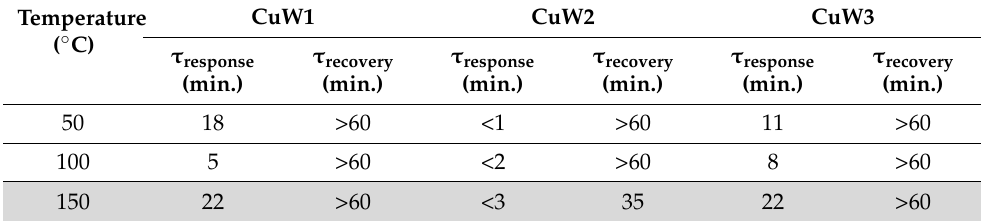
Figure 9. Sensor signal dependence with respect to the operating temperature after 10 ppm H 2 S exposure under 50 % relative humidity (RH) background ( a ); raw data of CuW1, CuW2, and CuW3 operated at 150 °C for one pulse of 10 ppm H 2 S ( b ). Table 3. Response/recovery times to H 2 S exposure for different operating